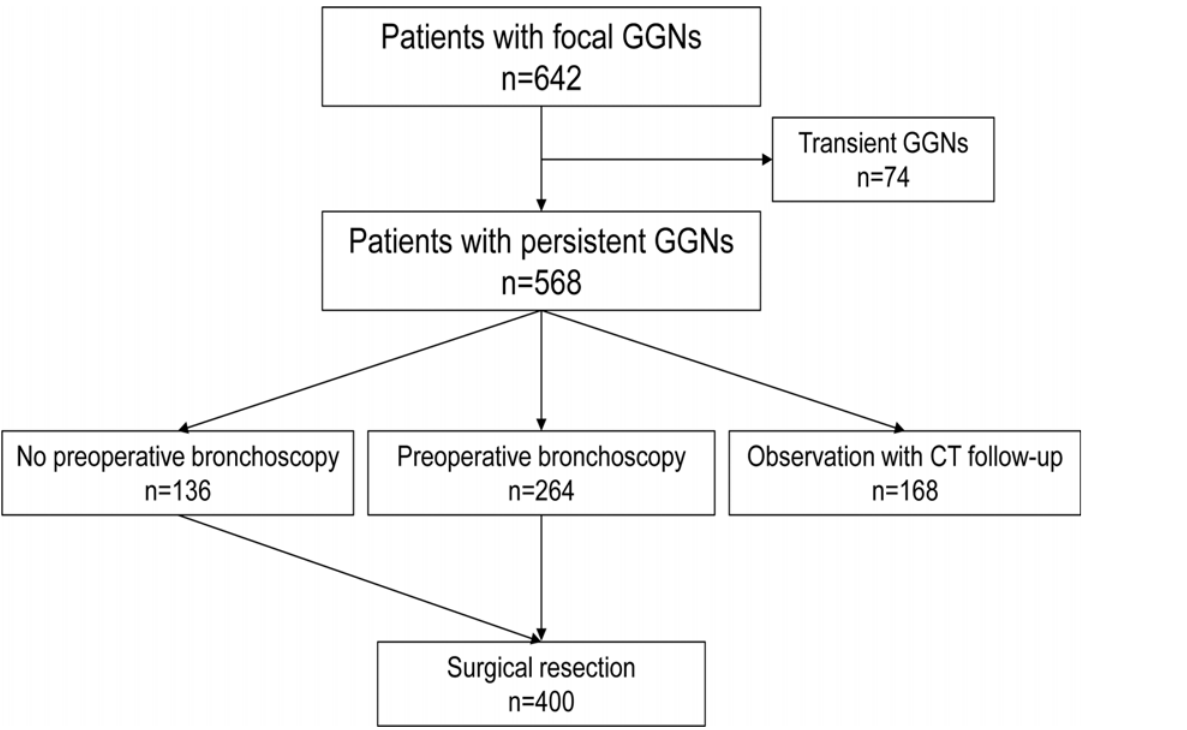
Fig 1. Diagram of the management for patients with a GGN on chest computed